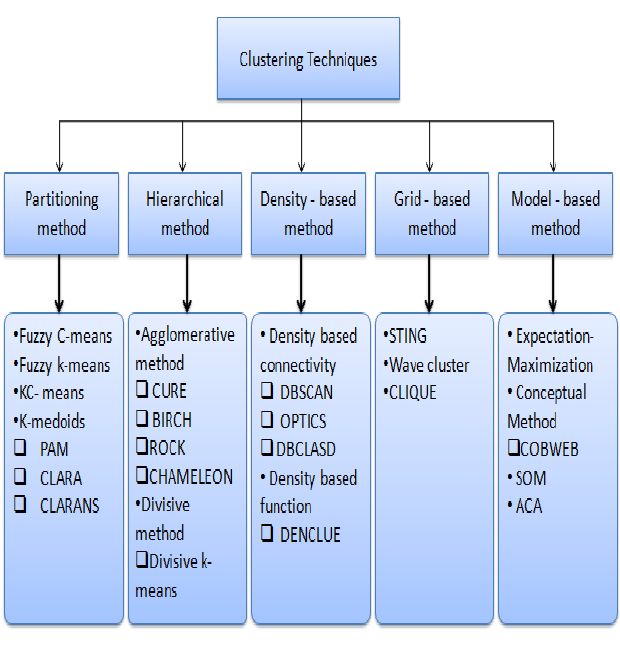
Fig. 2. Various clustering